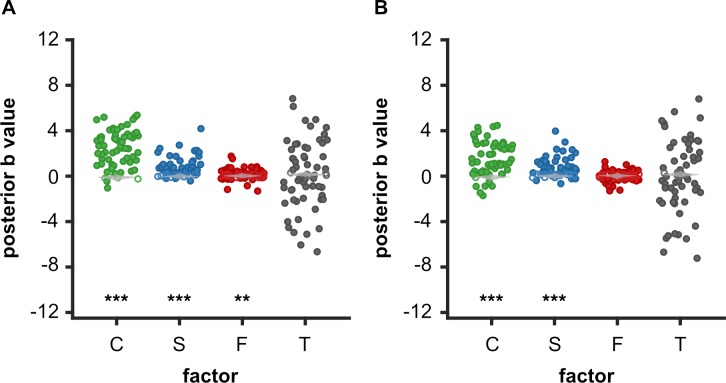
Model-based assessment of whether values are influenced by past actions.Posterior estimates of bias parameters were obtained using (A) BMA on all models (H0-H2) of ratings only (B) BMA on all extended models (H0-H3) of both rating and action-related variables. Bias parameters are the weights assigned to choices (C, green), success (S, blue), force (F, red) and time (T, grey) in equations used to update ratings (H1-H2) or values (H3). Each dot represents one subject. The violins (in light grey) represent the bootstrap distribution of the respective posterior parameters under the null hypothesis (see Supplementary Material). Hollow dots represent subjects for whom the posterior estimate falls within the 95% credible interval of the null distribution. Significant deviation from the null (see Supplementary Material) is indicated as following: ** p<0.01; *** p<0.001.